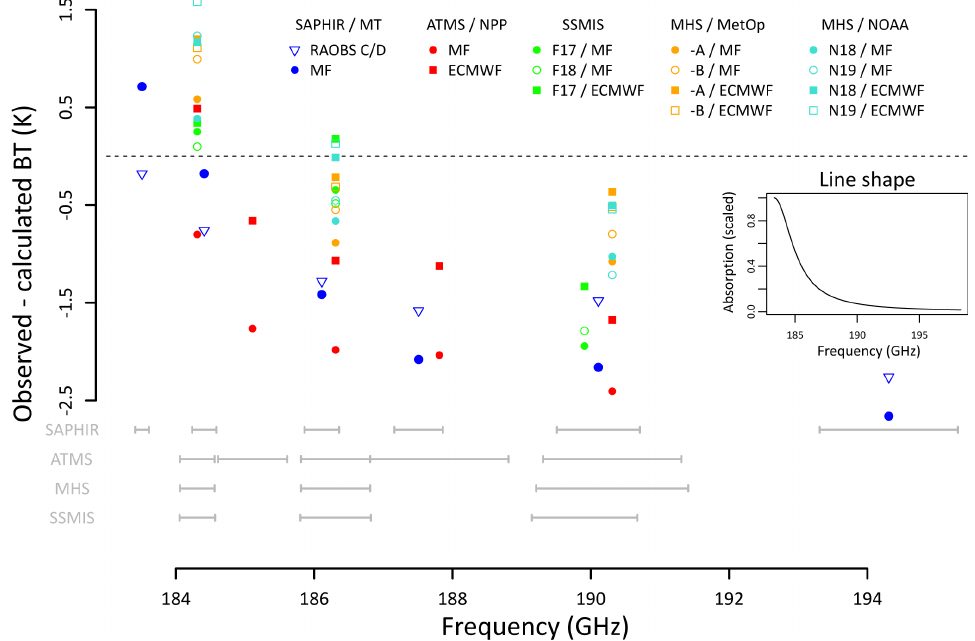
Figure 1. Mean observed BT minus calculated BT. All the calculated BTs are from RTTOVv11 run on RAOBs measurements (triangles) or Météo France NWP profiles (MF, circles) or European Centre for Medium-range Weather Forecasts NWP profiles (ECMWF, squares). Each color refers to a specific sensor, as in the legend. The horizontal gray bars indicate the width of the band passes. For simplicity, only one side of the absorption line is represented. The RAOB measurements were collected during the CINDY/DYNAMO/AMIE field campaign, winter 2011–2012. The inset is a scaled representation of the 183.31GHz line, assuming a Van Vleck–Weisskopf shape. Table 1. List of satellites, sensors and their channels located in the f 0 = 183.31GHz absorption line. To reach the required radiometric accuracy, the sensors are double-sided channels (except channel 3 of MHS), with the same bandwidth on each side; for each channel, radiation is measured over each side and